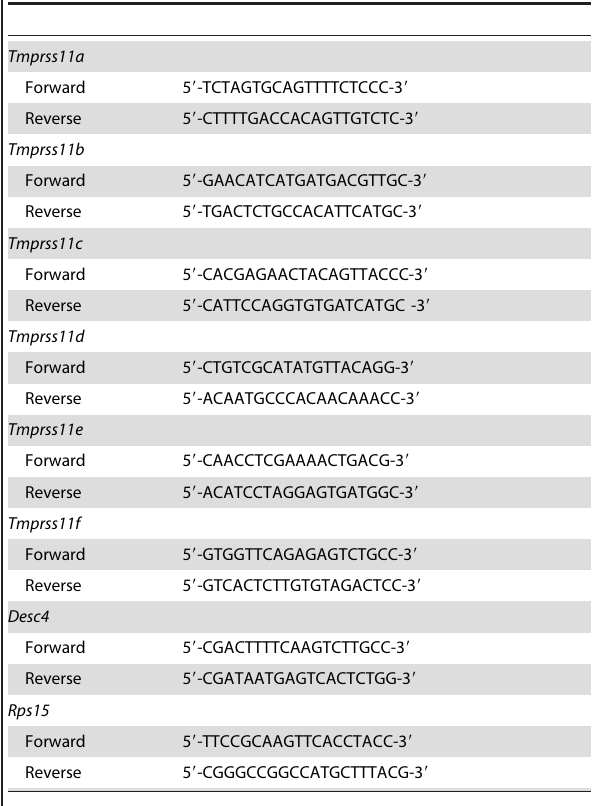
Table 1. Sequences of primers used for expression analysis of HAT/DESC genes in mouse tissues.